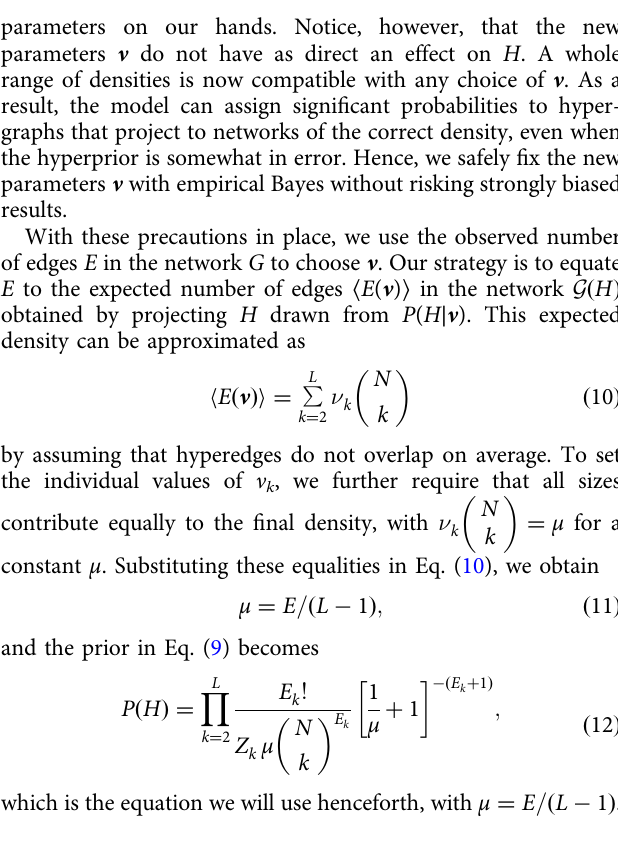
Fig. 2 Encoding hypergraphs as factor graphs. The two panels show the factor graph encoding of two different hypergraphs that project to the same network, shown at the bottom of the fi gure. a A hypergraph without higher-order interactions is obtained by associating each edge in G (blue lines) to a node in the factor graph (empty circles); this correspondence is illustrated with a dashed line. Each node in the factor graph is then connected to a factor A ij (squares) where ( i , j ) is the corresponding edge in G . Higher-order factors A ijk corresponding to possible hyperedges of three nodes are also added and connected to the edges ( i , j ), ( j , k ), ( i , k ) they comprise. Since there is no 4-clique in the graph, the construction stop at this step. A particular combination of hyperedges can then be speci fi ed by activating some factors (coloring them blue), here all the factors corresponding to the edges. b To encode a hypergraph H with one higher-order interaction, we mark the factor A 123 as